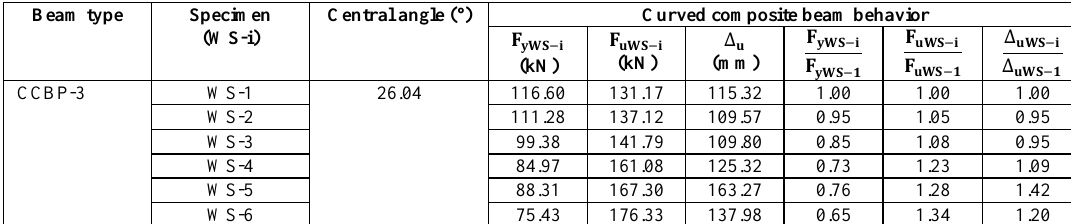
Figure 14. Yield, ultimate load-specimens relationship Table 5. Web stiffeners effect on the curved composite beam.